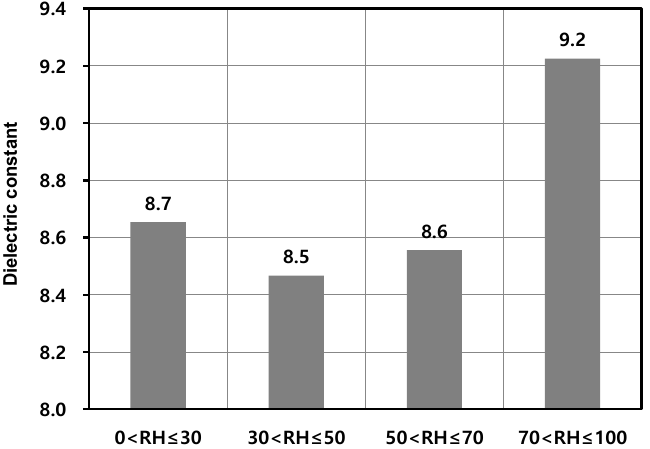
Figure 7. Means of the four groups of bridges classified according to relative humidity: RH ≤ 30% (Group R1), 30% < RH ≤ 50% (Group R2), 50% < RH ≤ 70% (Group R3), 70% < RH (Group R4).